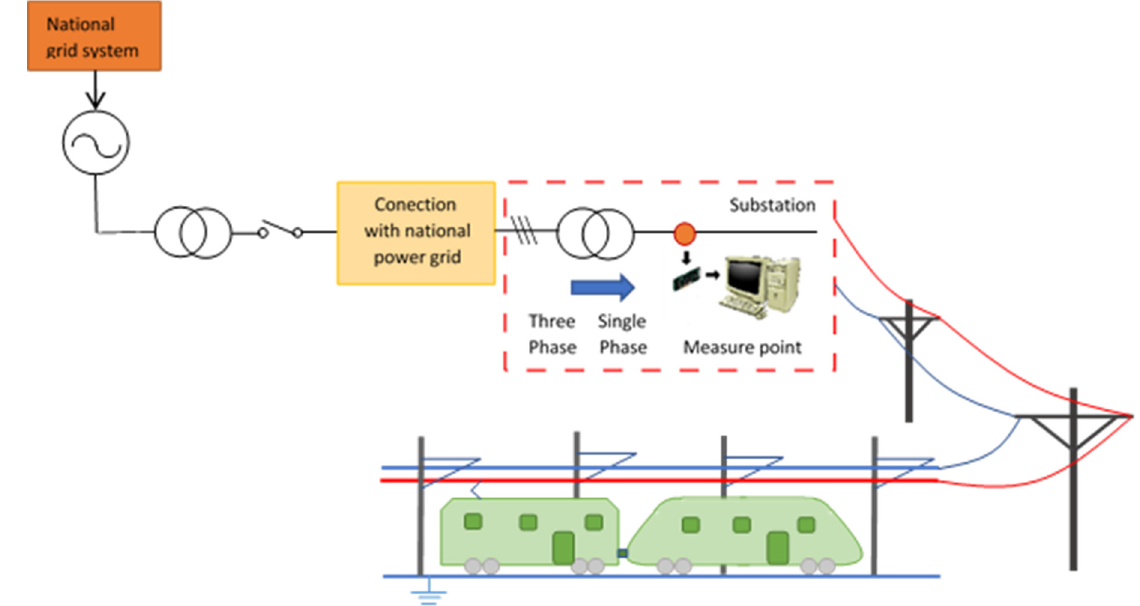
Figure 1. The measurement point in an electrified railway substation.